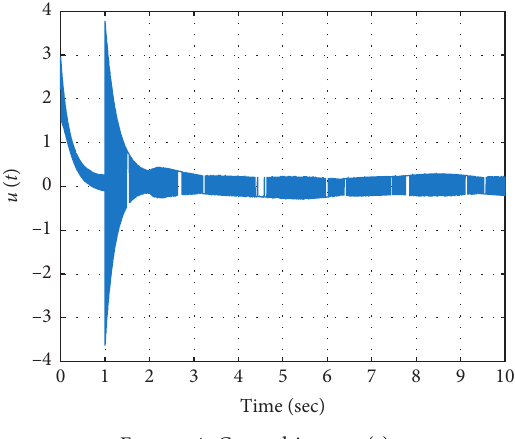
Figure 1: Trajectories of state x ( t ) .